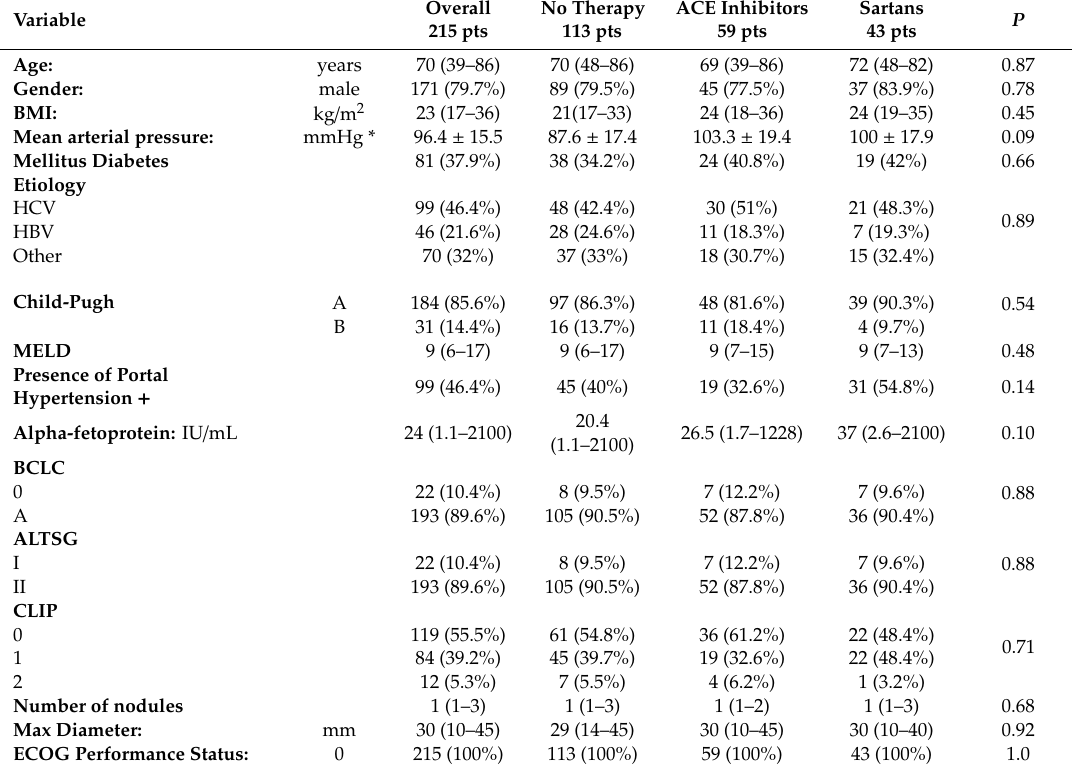
Table 1. Baseline characteristics of the study